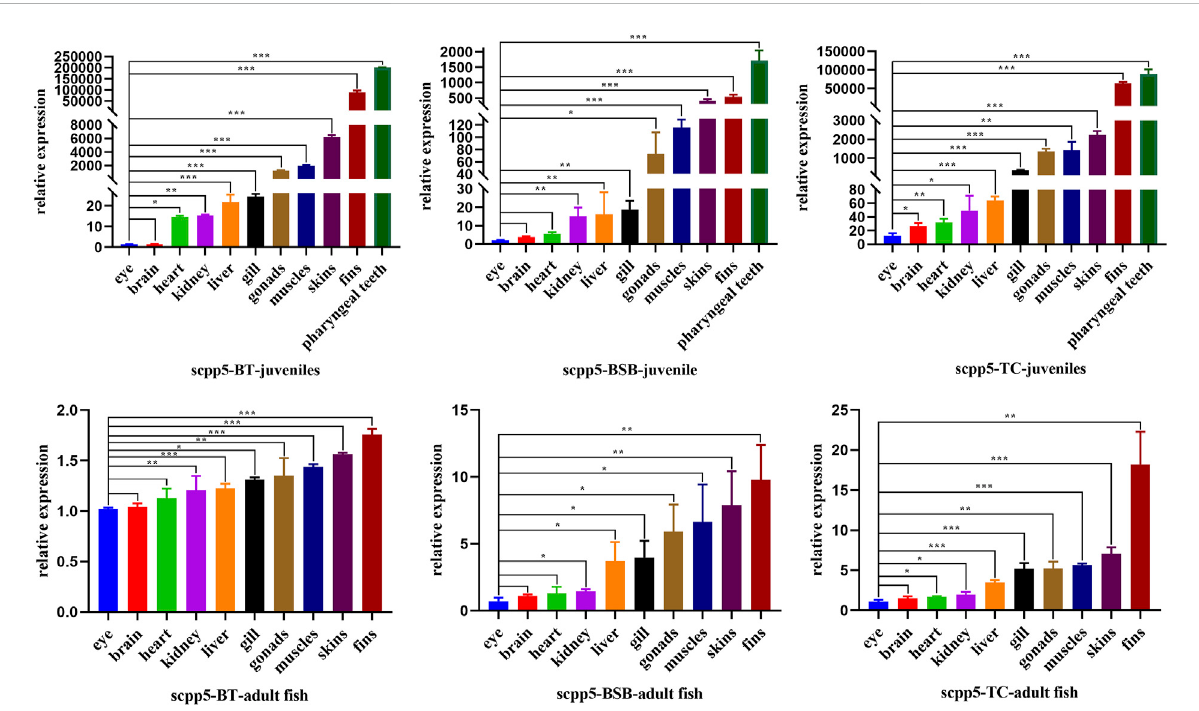
FIGURE 4 Scpp5 expression in pharyngeal teeth, brain, gill, heart, liver, muscle, skin, fi ns, gonad, eye, and kidney of BT, BSB, and TC were determined by quantitative realtime PCR. Data are plotted as mean ± SE of three independentexperiments. The β -actin gene is used as an internal positive control. Evaluation of the variation between the results was performed using the one-way ANOVA test. * means 0.01 < p < 0.05, ** means 0.001 < p < 0.01, and *** means p <